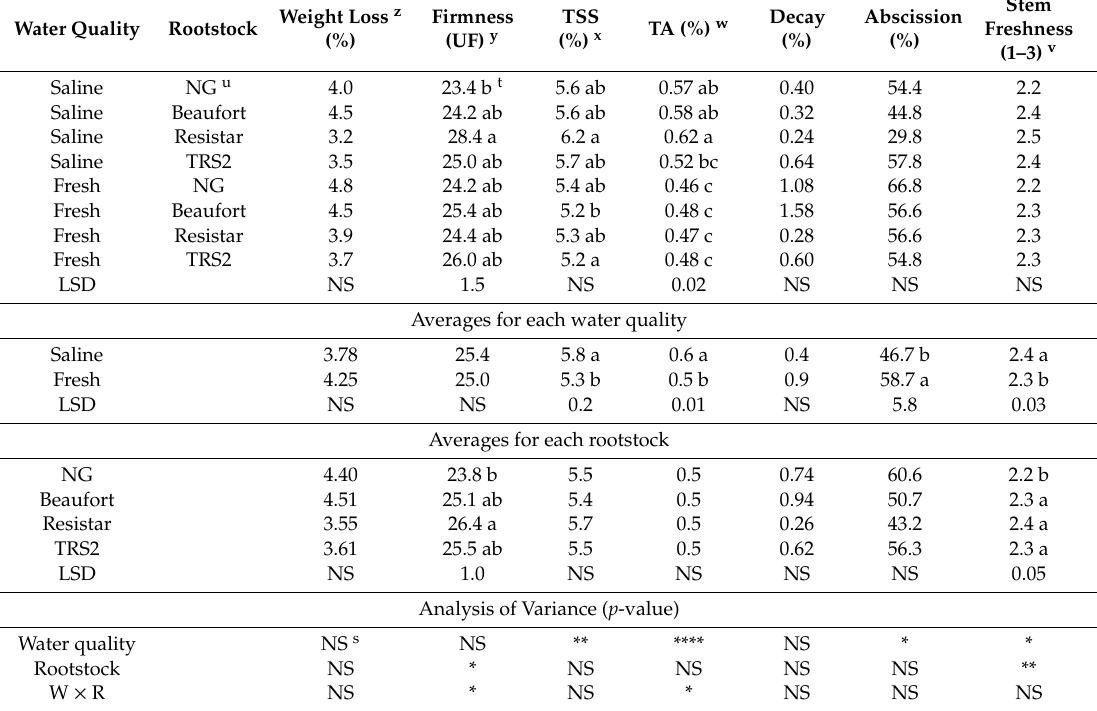
Table 2. Influence of water quality and grafting on ‘Lorka’ cherry tomato external and internal fruit-quality parameters after 12 d at 12 ◦ C plus 2 d at 20 ◦ C (Means of 5 harvests). Water